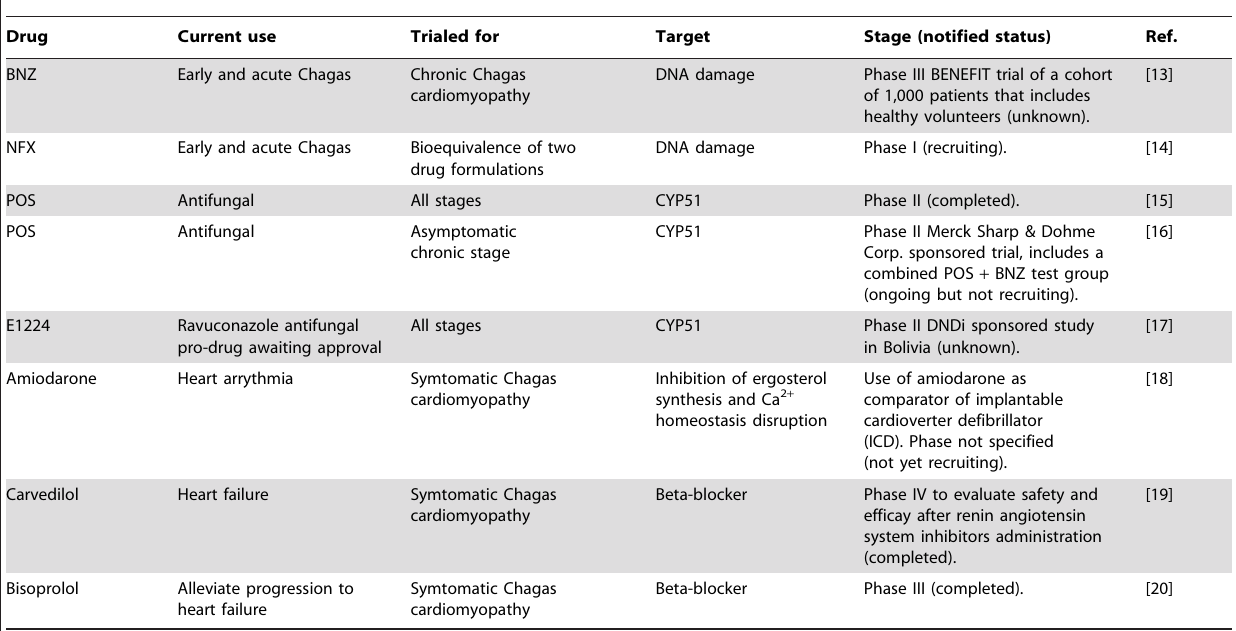
Table 1. Current status of clinical trials against Chagas disease.